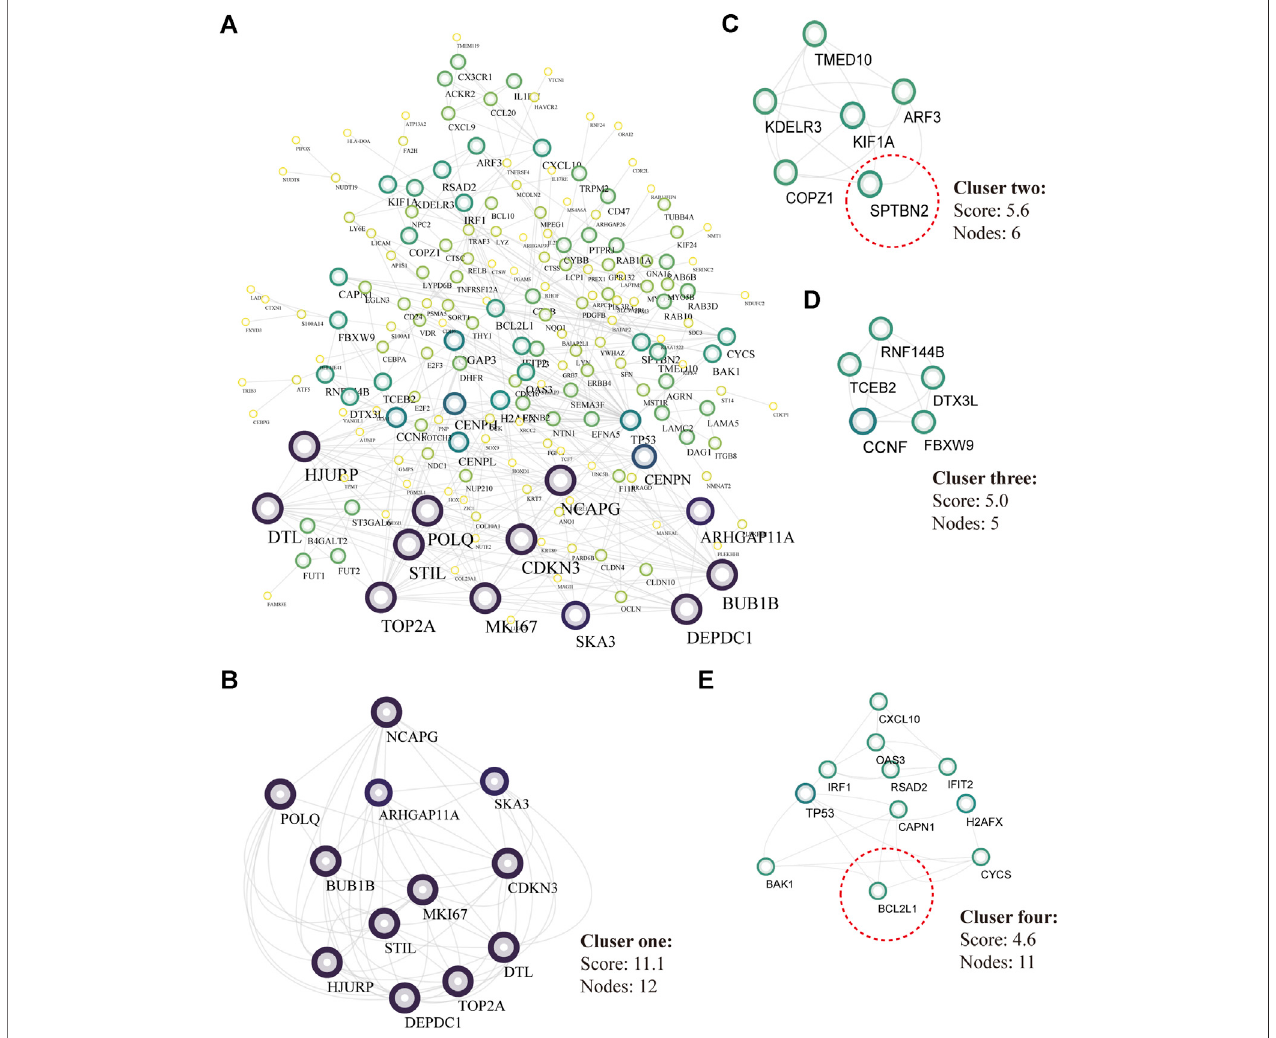
FIGURE 6 | PPI analysis and core modules of the putative target genes. (A) PPI network analyzed by the STRING database and built by Cytoscape software (K-score > 2,thecircularsizesrepresentedthedegreescoreevaluatedbyMCODEplugin). (B) Coreclusteroneincluding12nodes(cutoffscore (cid:2) 11.1). (C) Corecluster two including six nodes (cutoff score (cid:2) 5.6). (D) Core cluster one including fi ve nodes (cutoff score (cid:2) 5.0). (E) Core cluster one including 1,156,556 nodes (cutoff score (cid:2)